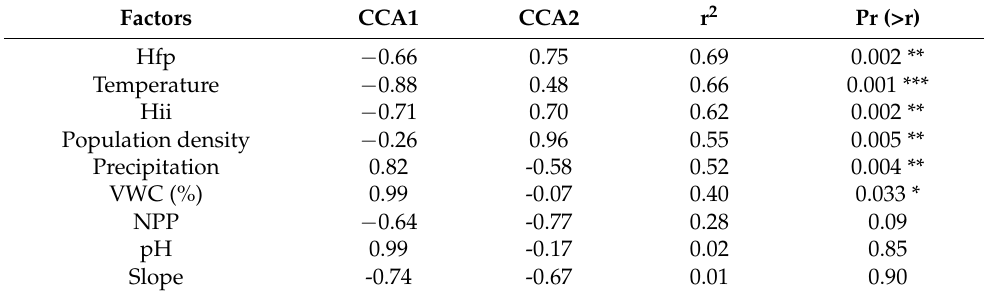
Table 2. Monte Carlo significance test of the environmental factors and plant species altitudinal distribution.